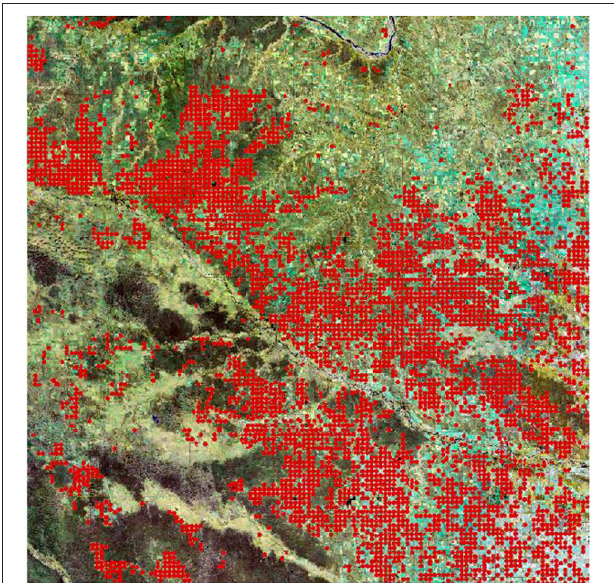
FIGURE 2 | Deep learning model output for test Image 2. This figure shows the predicted CPIS locations (red) from the deep learning model over a 100 × 100km test image. This image was not used in the training process of the model, so it should be indicative of how the model performs on previously unseen images with environments similar to the training images. As can be seen in the upper right hand side of the figure, the model is able to distinguish farmland irrigated by CPIS from farmland that is irrigated by some other